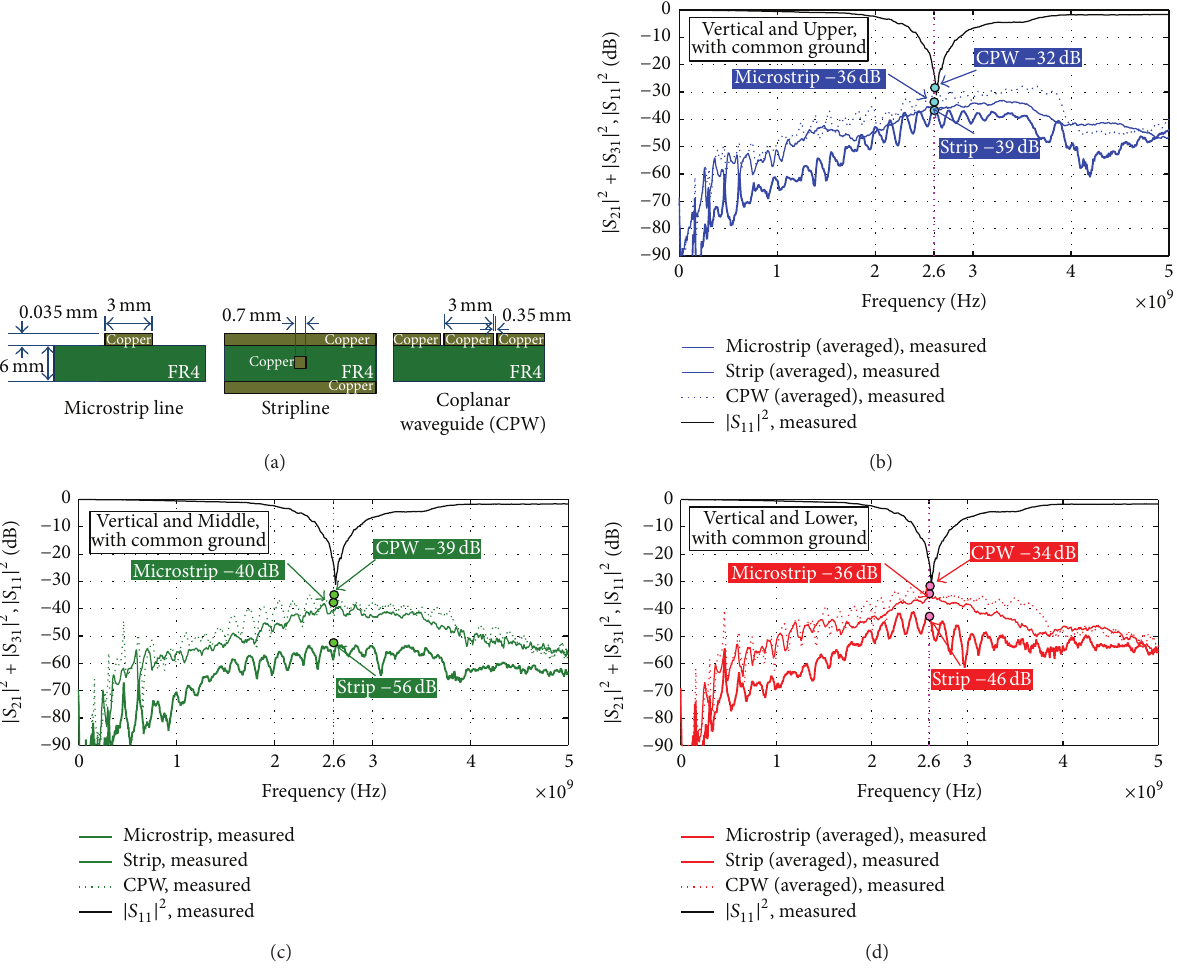
Figure 13: Measured power transfer from antenna to the multiple (five) transmission lines for three different types of transmission lines: microstrip, stripline and CPW. The grounds are connected between the antenna and board, and the five transmission lines are vertically positioned. (a) Cross-sectional view of three types of transmission lines, (b) comparison of transferred power to the transmission lines at Upper position, (c) comparison of transferred power to the transmission lines at Middle position, and (d) comparison of transferred power to the transmission lines at Lower